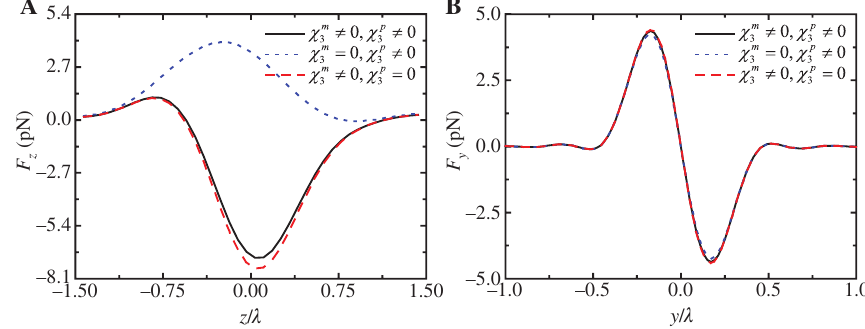
Figure 2: The force profiles for both the particle and solvent with and/or without optical nonlinearities at 420 nm. (A) The longitudinal force profiles on the z -axis ( x = y = 0) and (B) transverse force profiles on the y -axis ( x = z = 0).